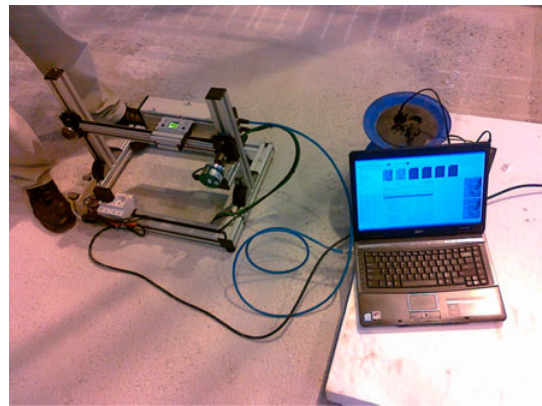
Fig. 10. Testing by means of non-destructive optical tech- nique